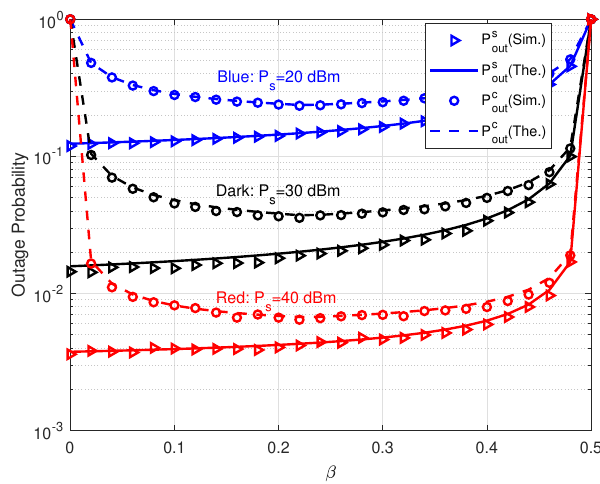
Figure 5. Outage probabilities versus β with different P s .